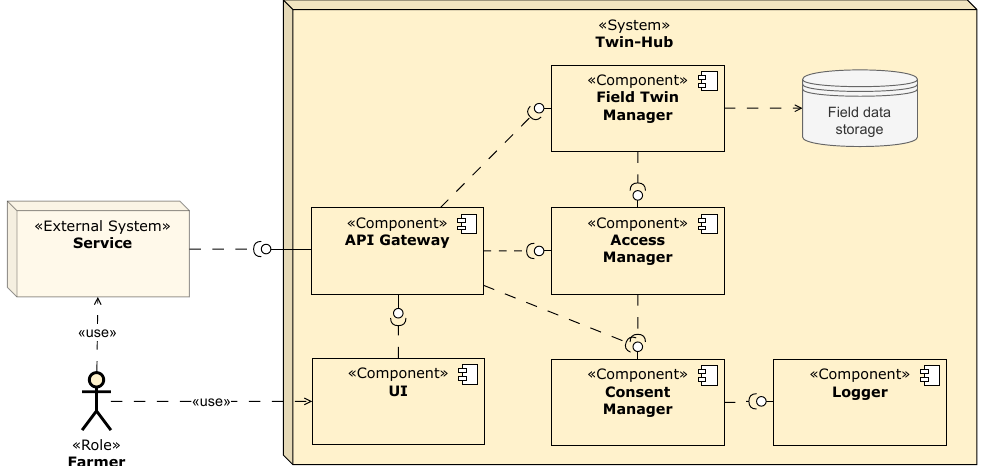
Figure 8. Further functional decomposition of the Twin-Hub, now including the components Access Manager and